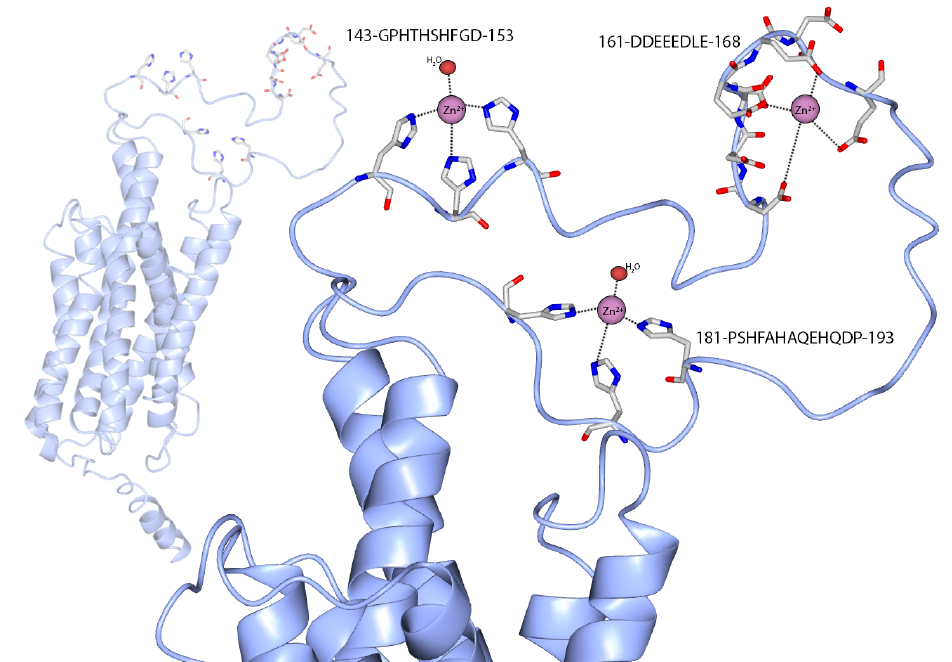
Figure 8. Representation of Zn 2+ complexes with Zrt2 protein according to the obtained metal coordination modes at acidic/physiological pH. Each fragment can act as an independent metal binding site. The figure was generated using CCP4mg [36]. The 3D structure of Zrt2 was predicted using AlphaFold [7].